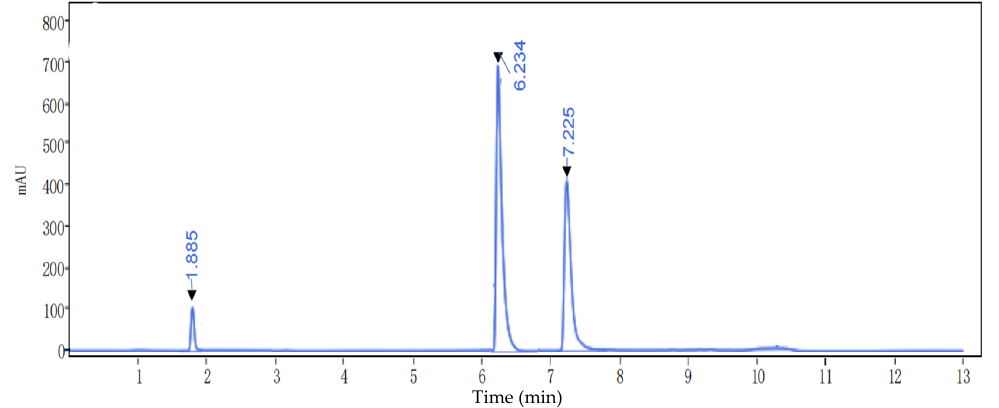
Figure 1. HPLC profiles of three standard samples at 280 nm.